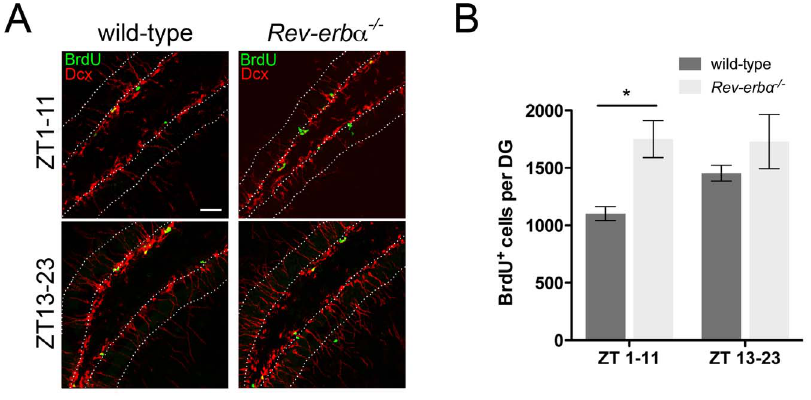
Figure 6. Neurogenesis in Rev-erb a 2 / 2 mice is constantly high and not diurnal. ( A ) BrdU was injected at ZT1 (upper panels) or ZT13 (lower panels) and incorporation was assessed 10 hours later (ZT11 and ZT23, respectively) in wild-type (left panels) and Rev-erb a 2 / 2 KO (right panels). Antibodies recognizing Dcx are in red and antibodies against BrdU are in green. The dotted white lines mark the granular layer of the DG. Scale bar: 50 m m. ( B ) Quantification of the BrdU + cells after 10 hours. Rev-erb a 2 / 2 mice display more BrdU positive cells during the light phase (ZT1-11) compared to wild-type (mean 6 SEM, n=4, *p , 0.05, 2-way ANOVA) whereas in the dark phase (ZT13-23) no difference in the number of BrdU positive cells was observed between the genotypes.